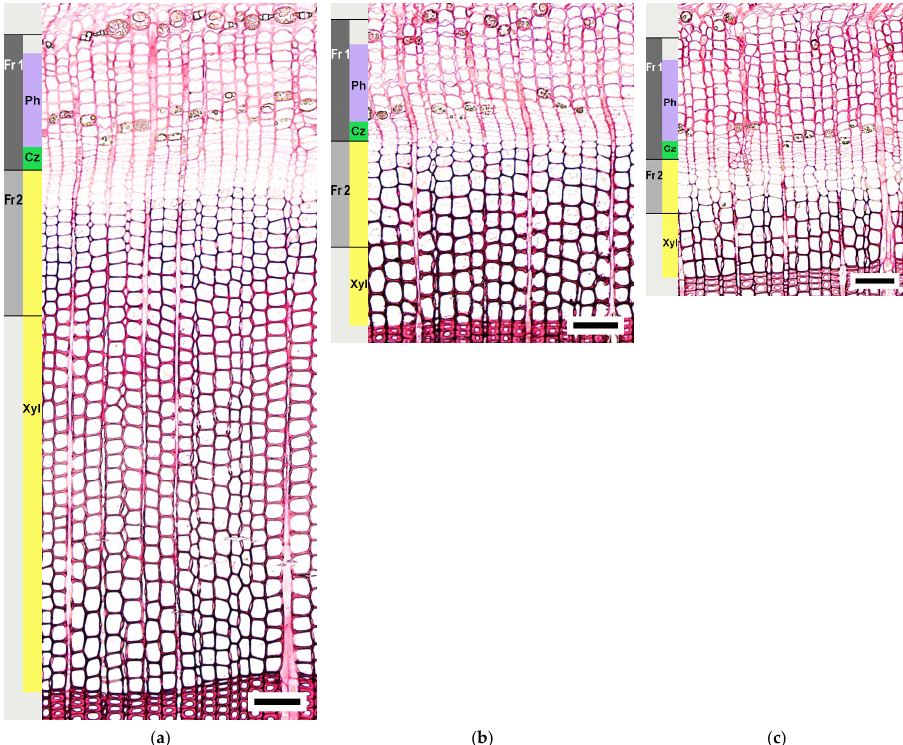
Figure 4. Transverse trunk tissue sections include conductive phloem (Ph), cambial zone (Cz), and current year xylem (Xyl) in 30-year-old ( a ), 70–80-year-old ( b ), and 170–180-year-old ( c ) pine trees. Scale bar = 100 µm. Samples collected on 21–22 June 2021. Tissues sampled for the identification of gene expression level indicated as Fr1 (Fraction1) and Fr2 (Fraction2).